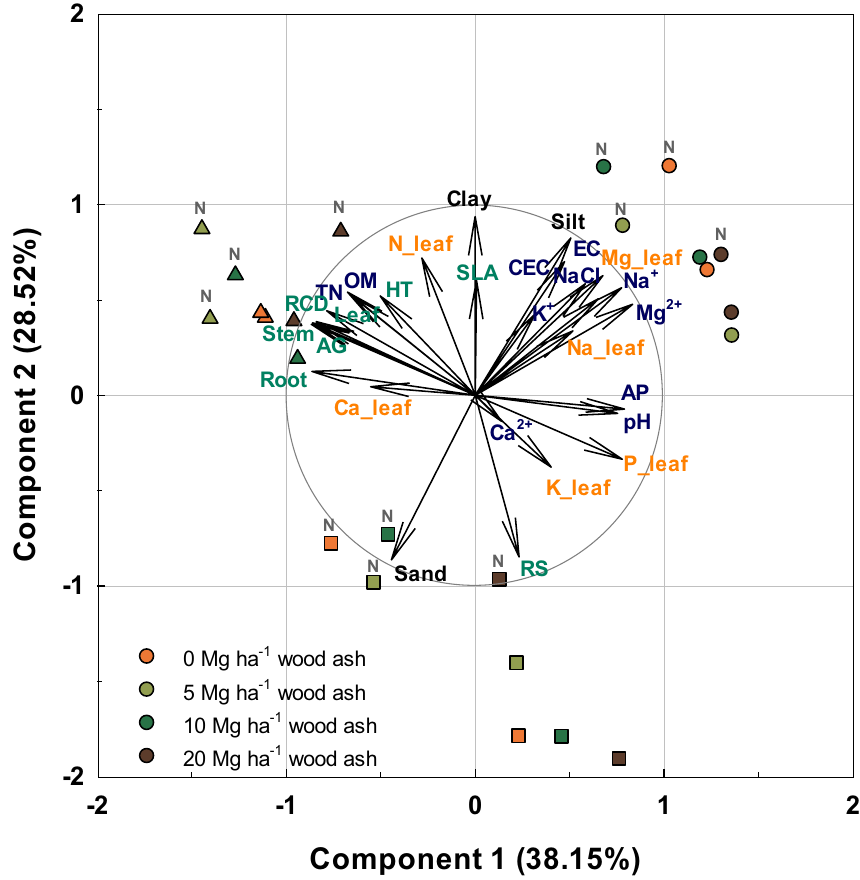
Figure 2. Principle component analysis (PCA) biplot based on the correlation matrix of soil characteristics and plant growth parameters across three soil types (landfill saline soil, forest infertile soil, and forest acidic soil) applied with four levels of wood ash (0, 5, 10, and 20 Mg ha −1 ) and two levels of N fertilizer (0 and 150 kg ha −1 ). Circle, square, and triangle represent landfill saline soil, forest infertile soil, and forest acidic soil. N above symbols denotes N fertilizer treated soil. OM, organic matter; TN, total nitrogen; AP, available phosphorus; CEC, cation exchange capacity, K, Ca 2+ Mg 2+ , Na + , exchangeable cations; Stem, stem biomass; Leaf, leaf biomass; Root, root biomass; AG, aboveground (stem + leaf) biomass; RS, root to shoot ratio; HT, height; RCD, root collar diameter; N_leaf, P_leaf, K_leaf, Ca_leaf, Mg_leaf, Na_leaf, leaf